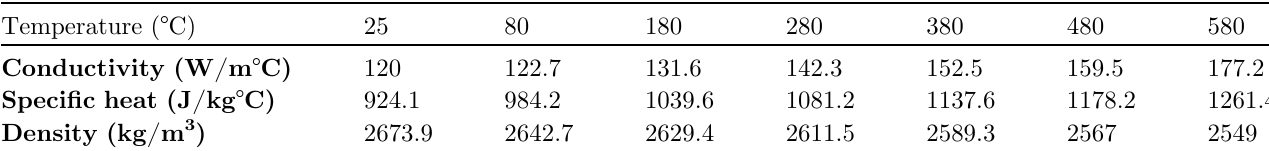
Table 2. Temperature-dependent material properties of aluminum alloy 5083